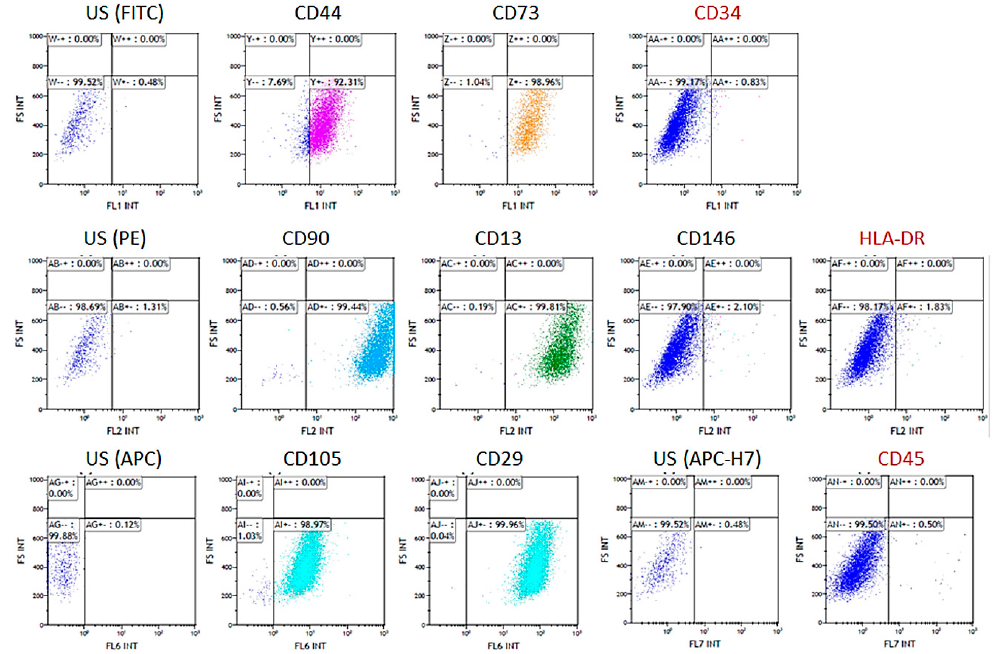
Figure 7. Cytofluorimetric analysis. Phenotypic expression pattern of primary cells isolated from human periapical cyst.